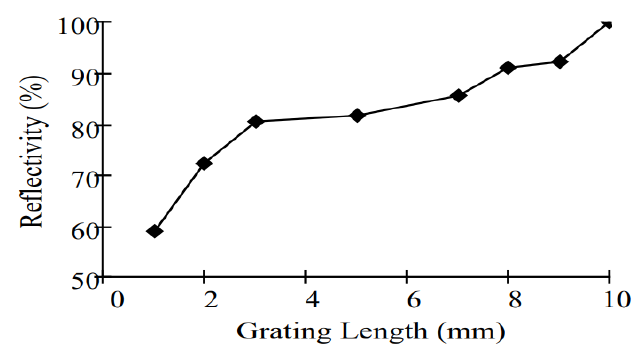
Figure 10. Relationship between FBG sensor reflectivity and grating length [15].